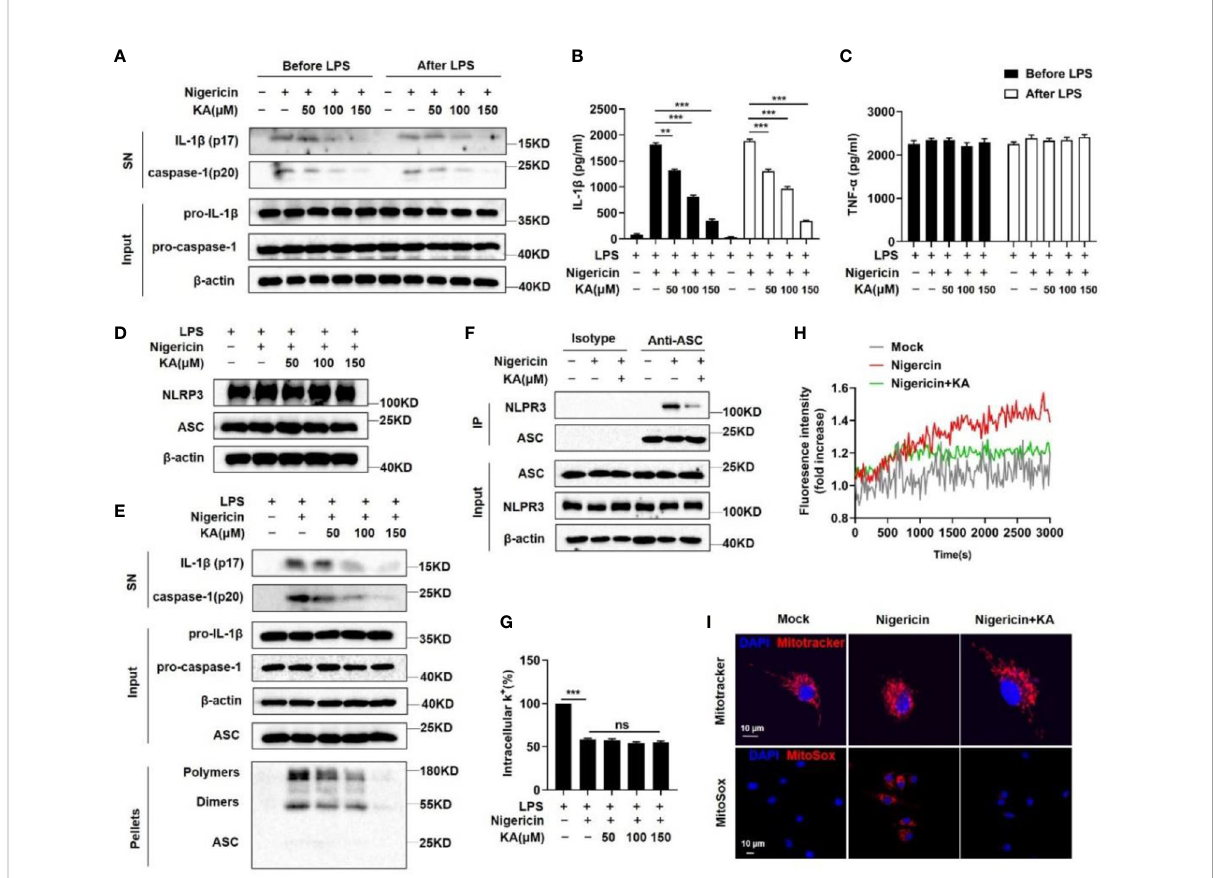
FIGURE 3 KA inhibits NLRP3 in fl ammasome assembly, Ca 2+ signalling, mitochondrial damage and mtROS production. (A-C) BMDMs were treated with KA and then stimulated with LPS (KA before LPS), or BMDMs were treated with LPS and then stimulated with KA (KA after LPS). After that, the cells were stimulated with nigericin. Western blot analysis of IL-1 b and cleaved caspase-1 in the SN of BMDMs and pro-IL-1 b and pro-caspase-1 in the lysates (input) of BMDMs (A) , ELISA of IL-1 b (B) and TNF- a in the SN of BMDMs (C) . (D) LPS-primed BMDMs were pretreated with KA for 2 hours and then stimulated with nigericin. Western blot analysis of NLRP3 and ASC in the lysates (input) of BMDMs. (E) Western blot analysis of IL-1 b and cleaved caspase-1 in the SN of BMDMs, pro-IL-1 b and pro-caspase-1 in the lysates (input) of BMDMs, and crosslinked ASCs in the NP- 40-insoluble pellet of BMDMs pretreated with or without KA. (F) Immunoprecipitation and western blot to evaluate the NLRP3-ASC interaction in BMDMs pretreated with or without KA. (G) Quanti fi cation of potassium ef fl ux in BMDMs pretreated with the indicated doses of KA. (H) Intracellular calcium in nigericin-stimulated BMDMs pretreated with or without KA was analysed by a Cytation 5 cell imaging multimode reader to measure fl uorescence intensity. (I) LPS-primed BMDMs were treated with KA and then stimulated with nigericin, followed by staining with MitoTracker red or MitoSox. Confocal microscopy analysis of MitoTracker (red) or MitoSOX (red) in BMDMs. Bars (10 µm) are in white, and nuclei (DAPI) are in blue. Data are representative of three independent experiments and show as the mean ± SEM. Statistical signi fi cance was analysed by unpaired t test: **p < 0.01, ***p < 0.001; ns, no signi fi